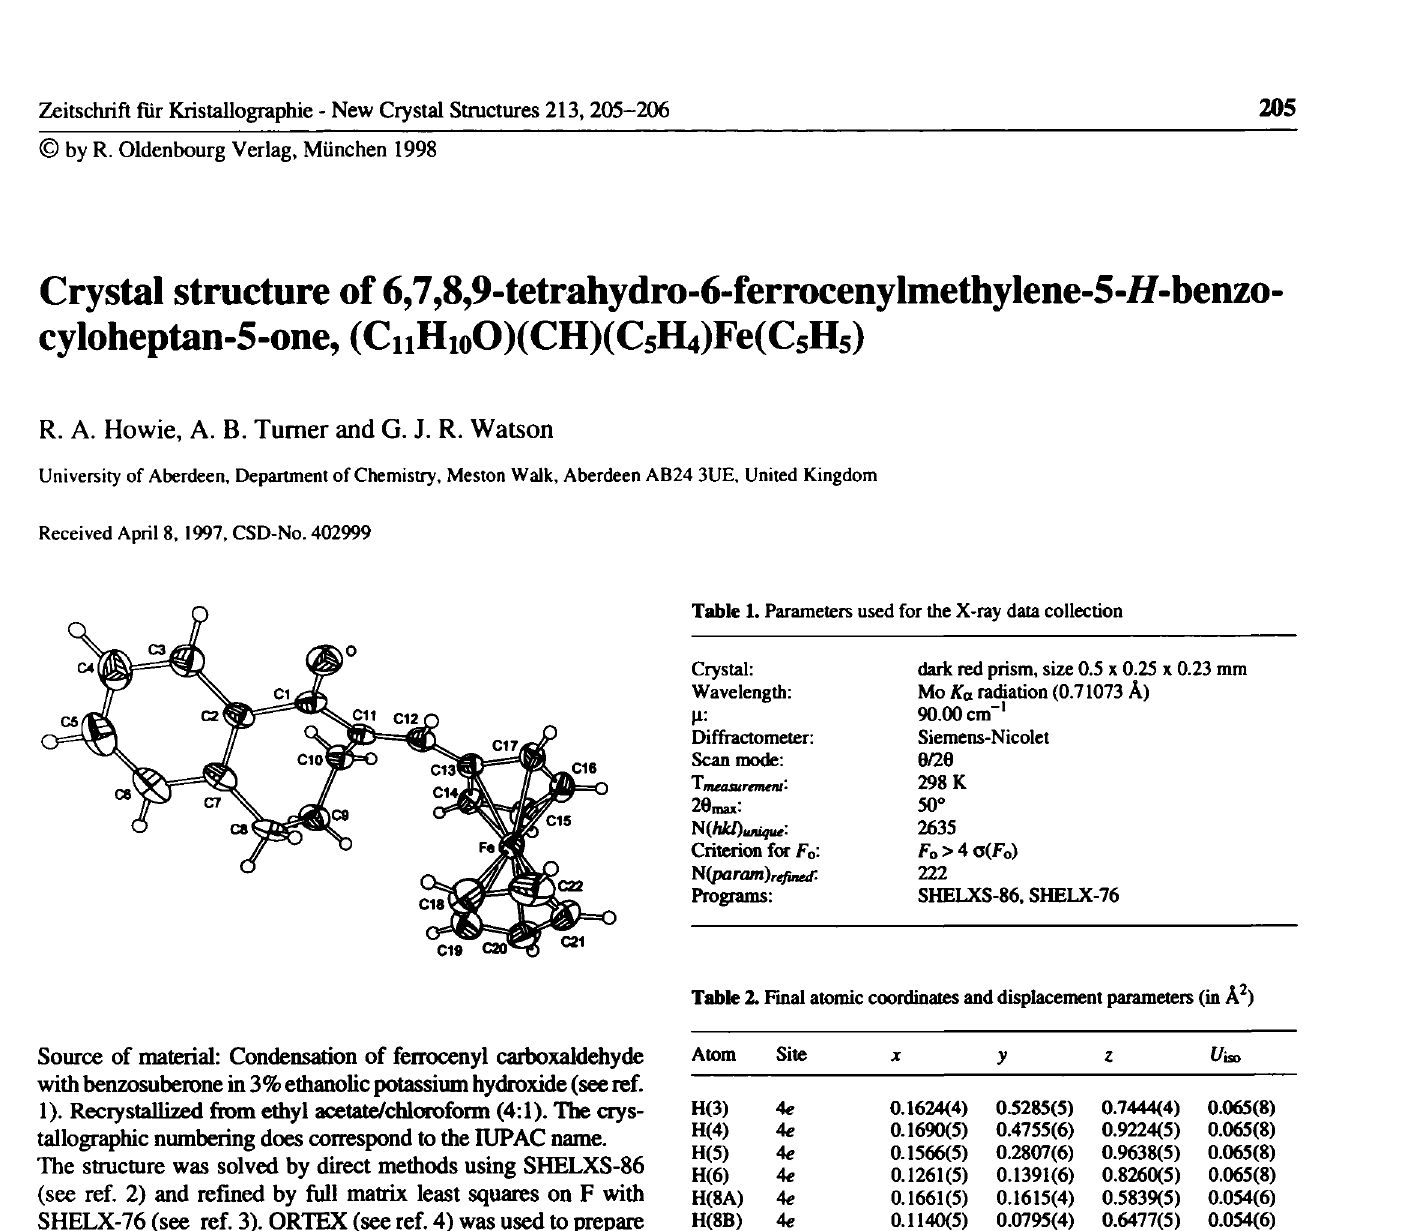
Table 3. Final atomic coordinates and displacement parameters (in A^)